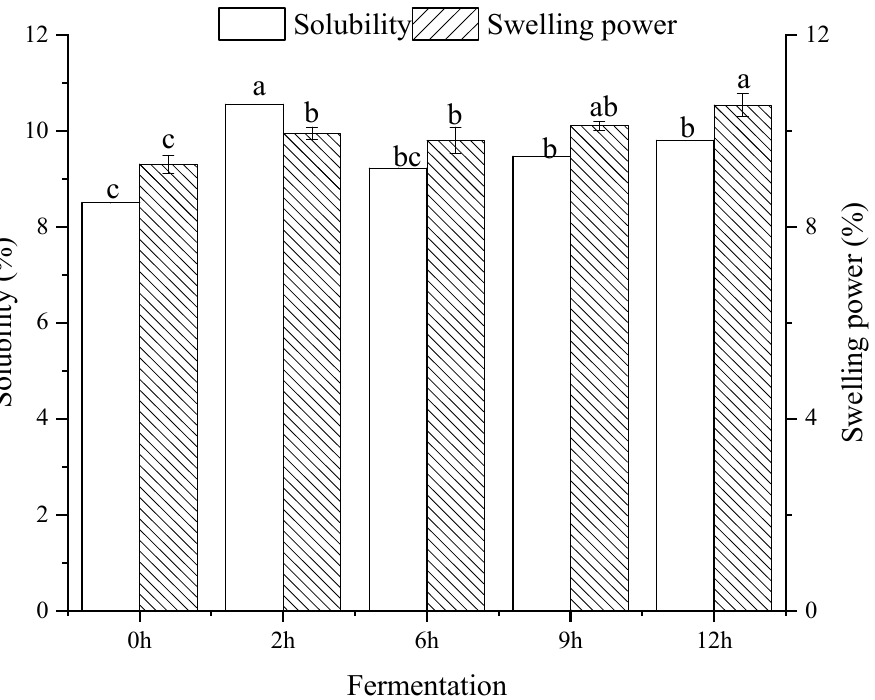
Figure 3. Solubility and swelling power of starch samples separated from bifidobacteria-fermented dough at different fermentation times. The representation of different letters have significant difference ( p < 0.05).